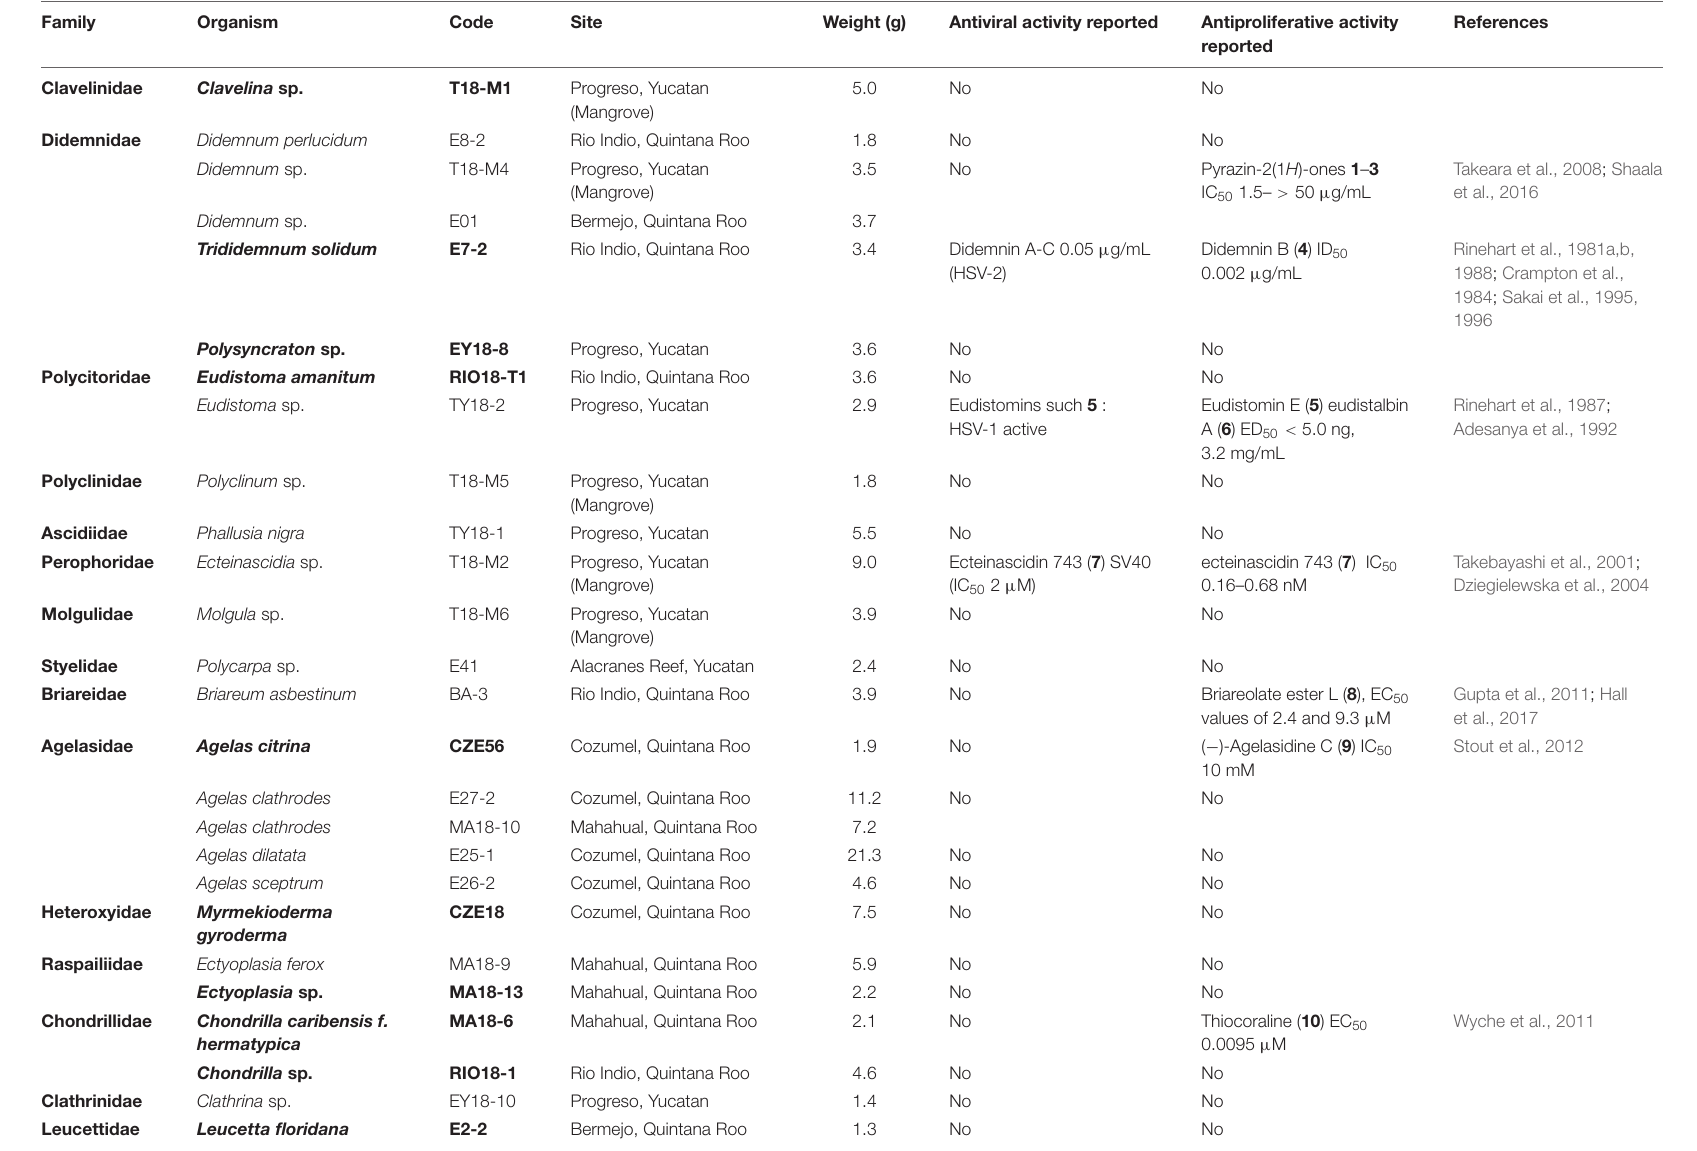
TABLE 1 | Taxonomic information, voucher numbers, site of collection, weight of the organic extract and previously activity reported for the species studied. Family Organism Code Site Weight